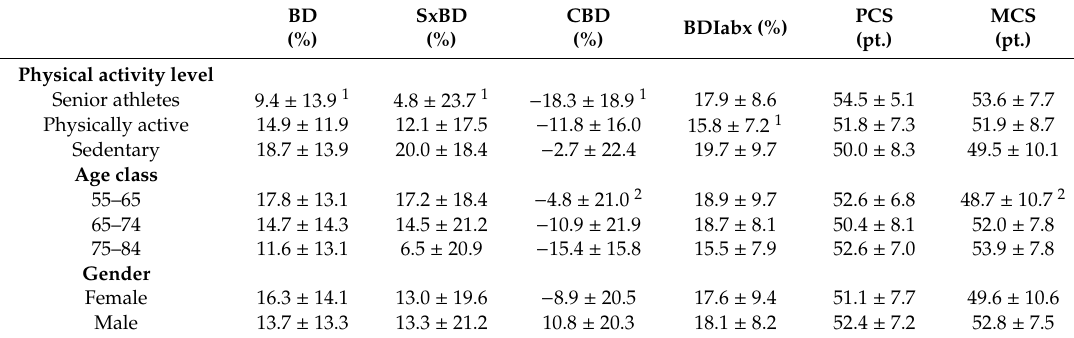
Table 3. BIDA and SF-12v2 indexes (pt) in relation to physical activity level, age class, and